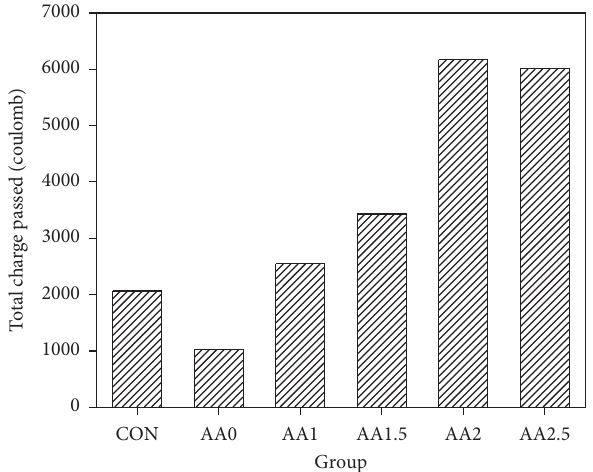
Figure 9: Total charge passed for each group